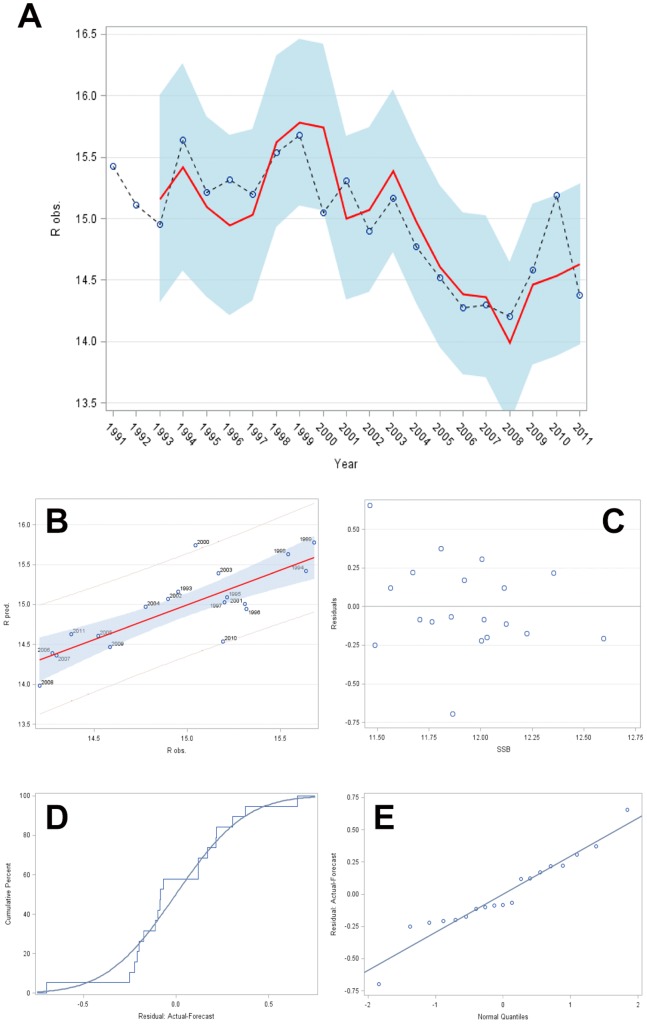
IMAX model panel plot with Robs., Rpred. and SSB on a log-scale.(A) Plot of observed and fitted loge(R) values of the IMAX recruitment model over time (years) with light blue prediction band (α = 0.05). (B) Plot of observed against predicted loge(R) values indicating good correspondence (r = 0.82, p<0.0001) with ∼67% of the recruitment variation explained by winter BSI and parental effects. The inner solid line represents the linear correspondence line, the two outer solid lines the 95% confidence interval related to the correspondence line, and the grey area the conic 95% forecast bands related also to the correspondence line. (C) IMAX model residuals plotted against loge(SSB) with non-systematic concentrations around the zero line. (D) Explorative distribution function (EDF) of the IMAX model residuals (stepped curve) fit by the cumulative distribution function (CDF) of the normal distribution (continuous line). (E) Q–Q plot of the IMAX model residuals assuming normality.